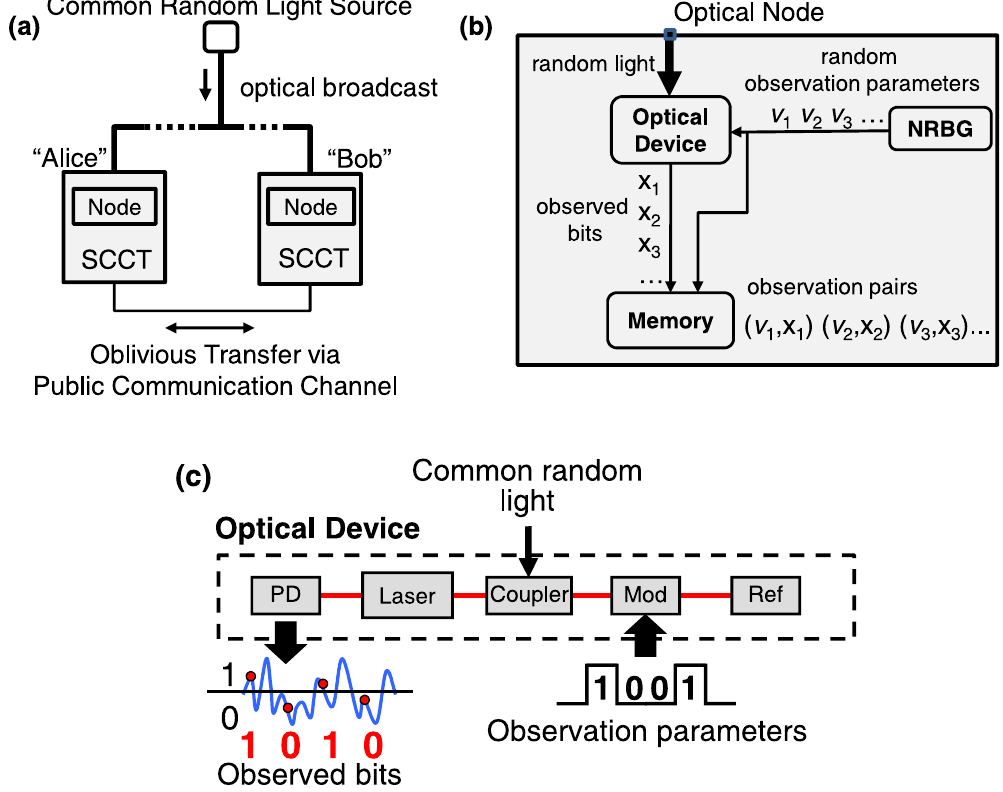
Figure 1. Schematic diagram of system for oblivious transfer using optical correlated randomness. ( a ) Total system, ( b ) optical node, and ( c ) optical device. ( a ) SCCT: secure communication and computation terminal. ( b ) NRBG: non-deterministic random bit generator. ( c ) Mod: optical phase modulator, PD: photodetector, and Ref: optical